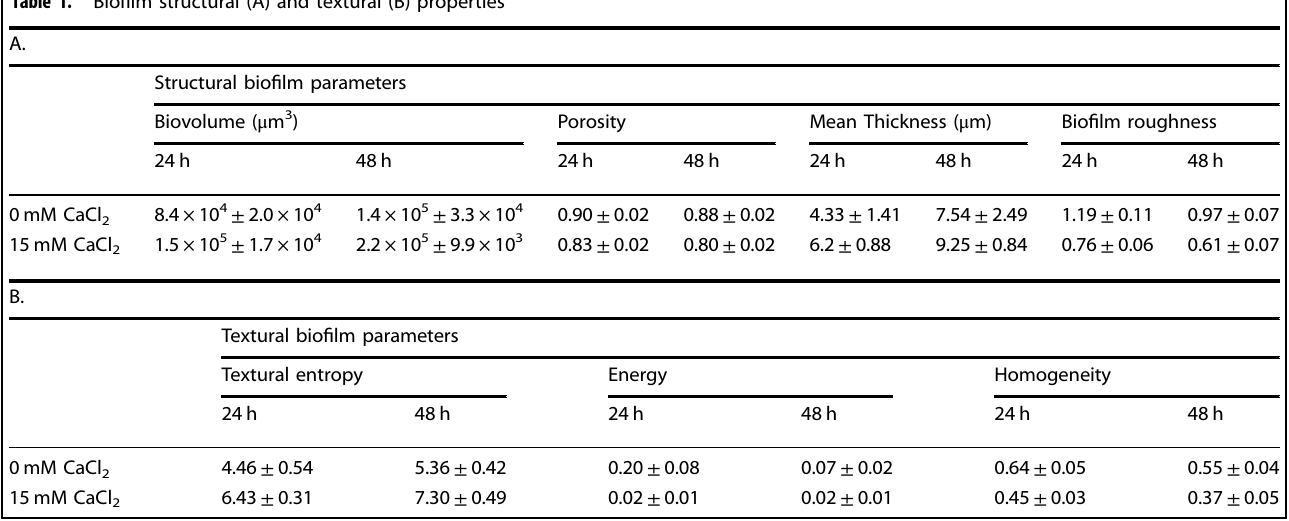
Table 1. Bio fi lm structural (A) and textural (B)